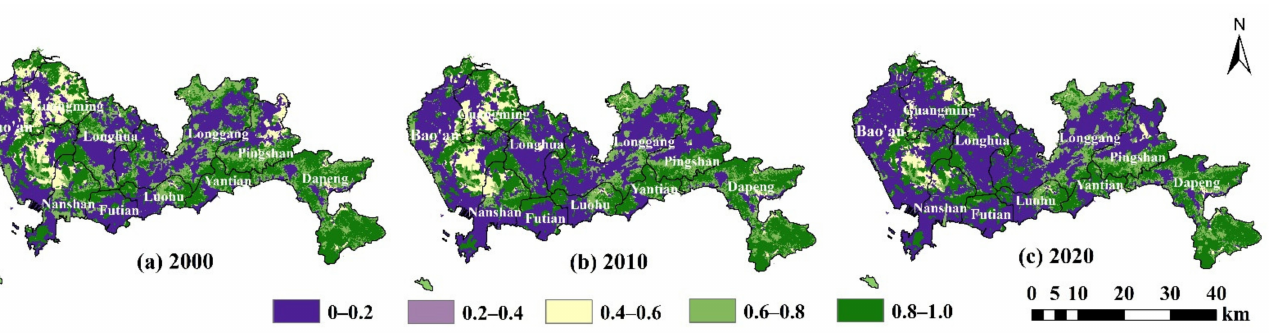
Figure 4. Habitat quality distribution of Shenzhen in ( a ) 2000, ( b ) 2010, and ( c ) 2020. According to the results of habitat quality, ten optimal habitat patches with large areas were extracted as ecological sources (Figure 5), with an area of 485.81 km 2 , accounting for 24.32% of the total study area. They were mainly the rural woodland to the southeast, the urban green land to the west, and forest park patches adjacent to Dongguan and Huizhou in the north. The urban sources of the western, southern, central, and eastern regions were identified, with a total area of 805.865 km 2 , accounting for 40.34% of the total study area.